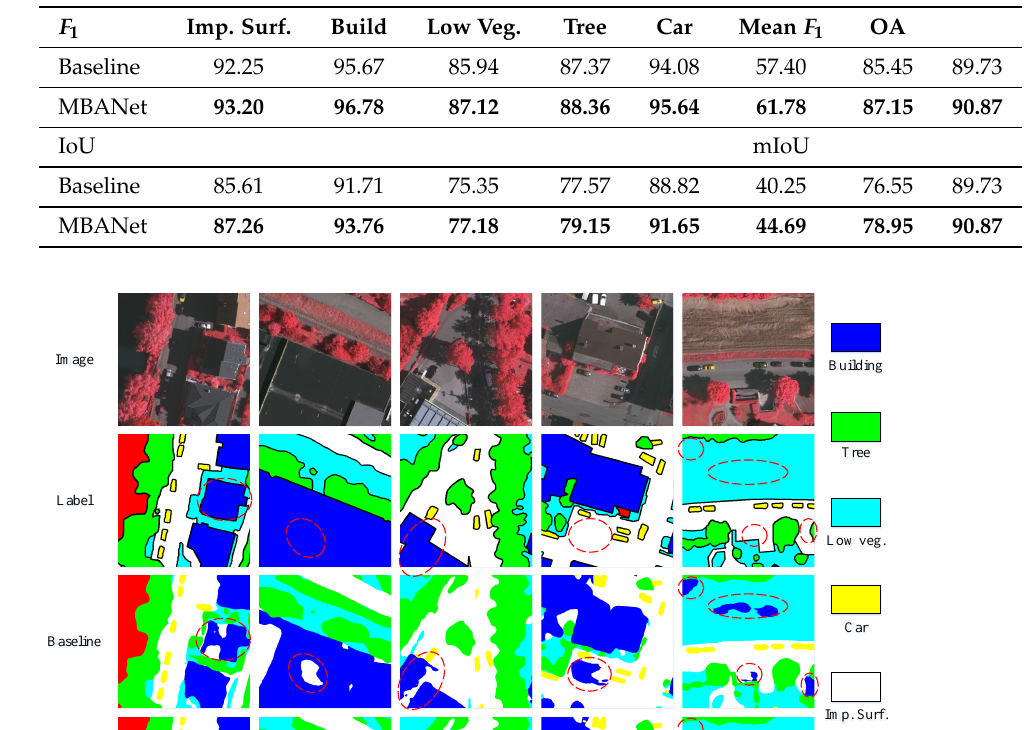
Table 9. Experimental results of the final model on the Potsdam dataset.